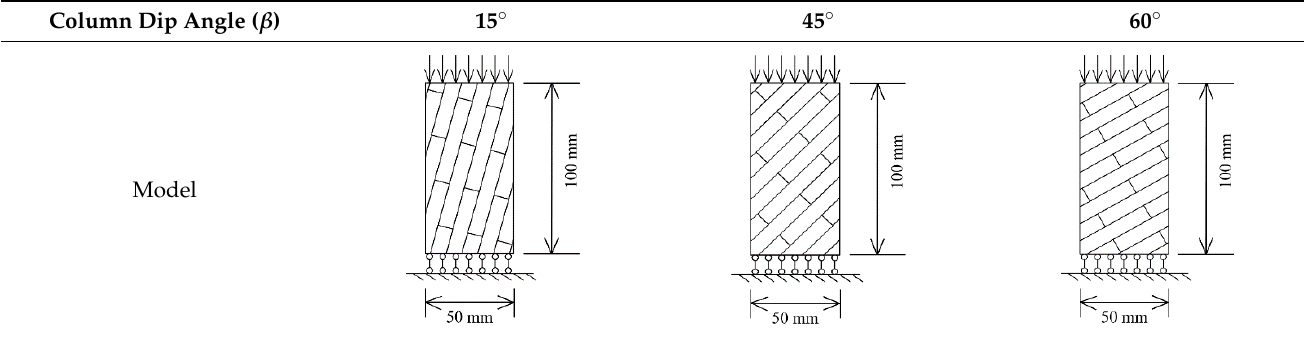
Table 1. The model geometry and load conditions used for verification.